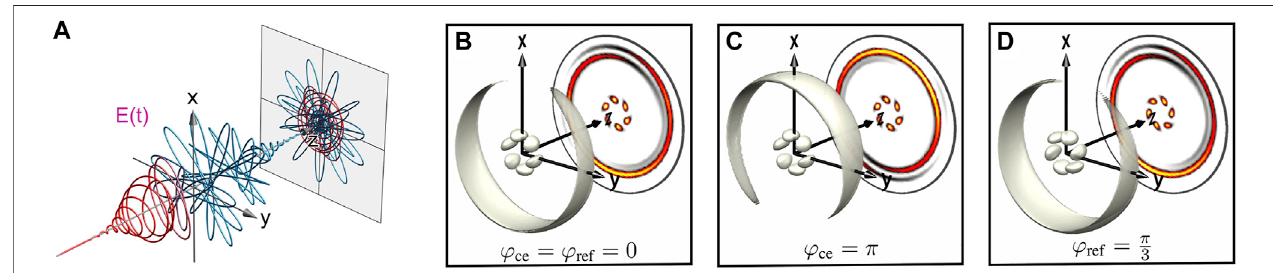
FIGURE 14 | (A) Trichromatic pulse sequence consisting of a circularly polarized single pulse temporally overlapping with a CRCP pulse sequence. While the pump-probe pulse sequence is given by a (3 ω :4 ω ) bichromatic fi eld, the additional green component exhibits a frequency ratio of 5:6 with respect to the probe fi eld. (B – D) show the resulting PMDs displaying a CEP-insensitive 6-armed inner vortex surrounded by a CEP-sensitive 1-armed outer vortex, for selected values of the CEP and the relative optical phase φ ref